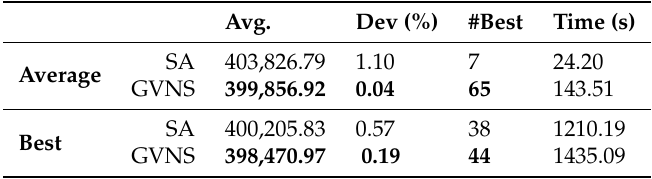
Table 6. Comparison with the